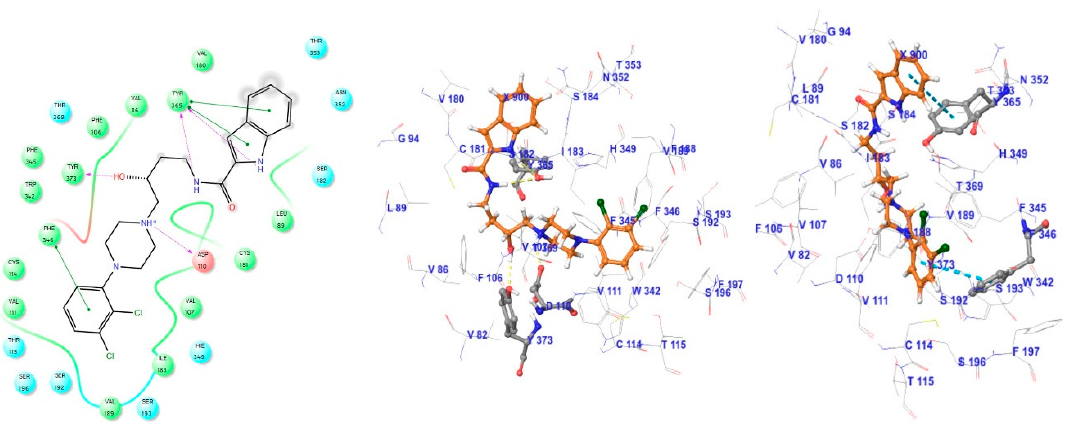
Figure 3. Docking pose showing the interaction between R-22 and 3PBL residues. In the left-hand picture, the blue line shows Pi-Pi stacking, the purple line shows hydrogen bond interaction and the yellow-green line shows hydrophobic interaction.